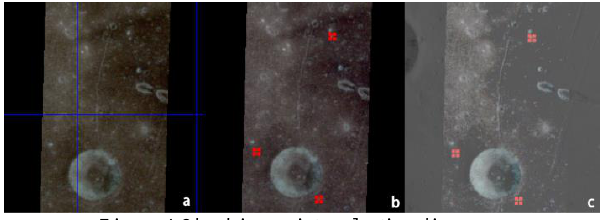
Figure 4 Checking points selection